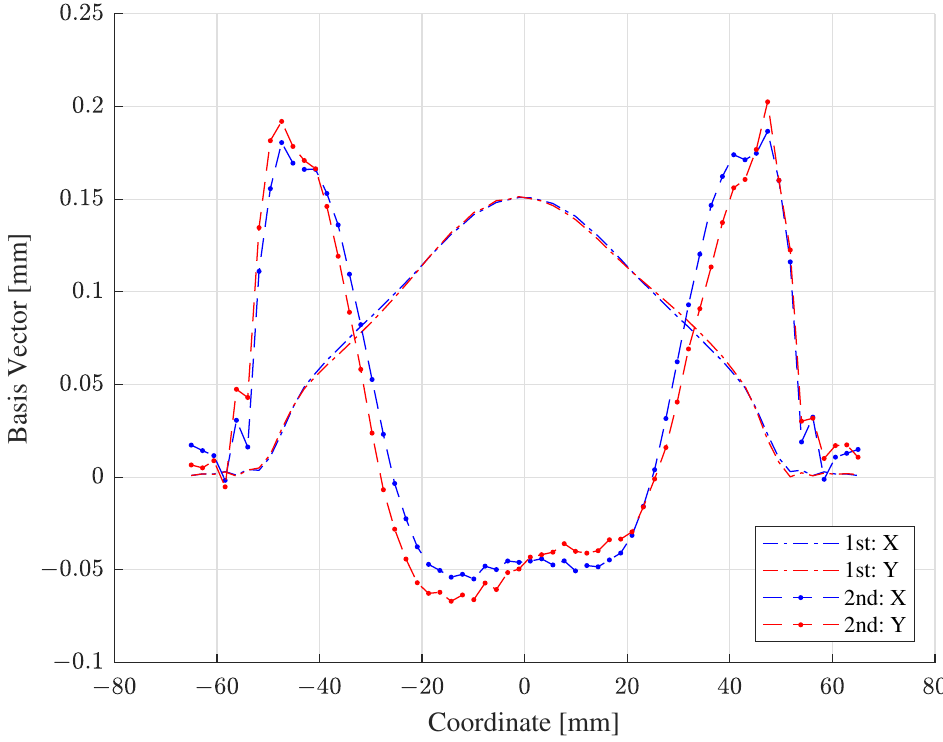
Figure 9. The 1st and 2nd basis vectors of the EMF simulation